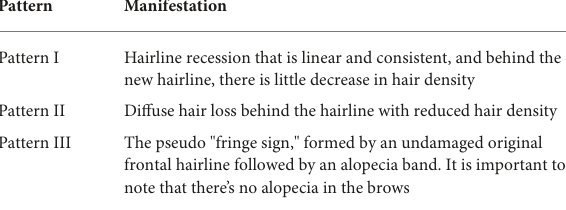
inflammatory lesions of LPP HFs, such as MHC class I and II β 2-microglobulin